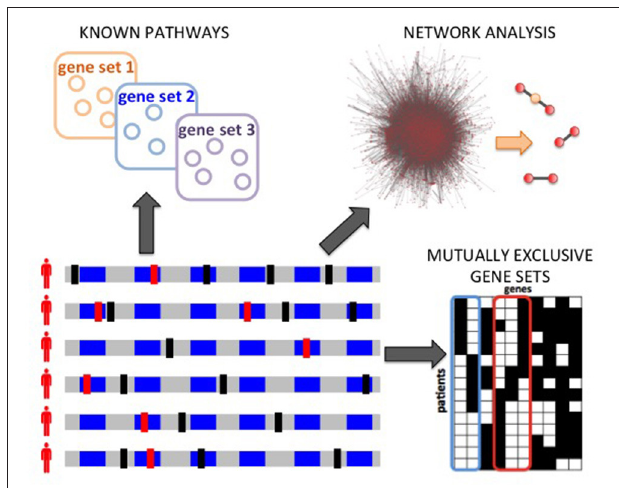
FIGURE 3 | Computational analyses to characterize inter-tumor heterogeneity. Starting from somatic mutations measured in many patients, different types of analyses are possible: annotation and enrichment analysis for known pathways; network analyses to discover significantly mutated subnetworks of a large interaction networks; the de novo identification of pathways, based for example on the identification of mutual exclusivity